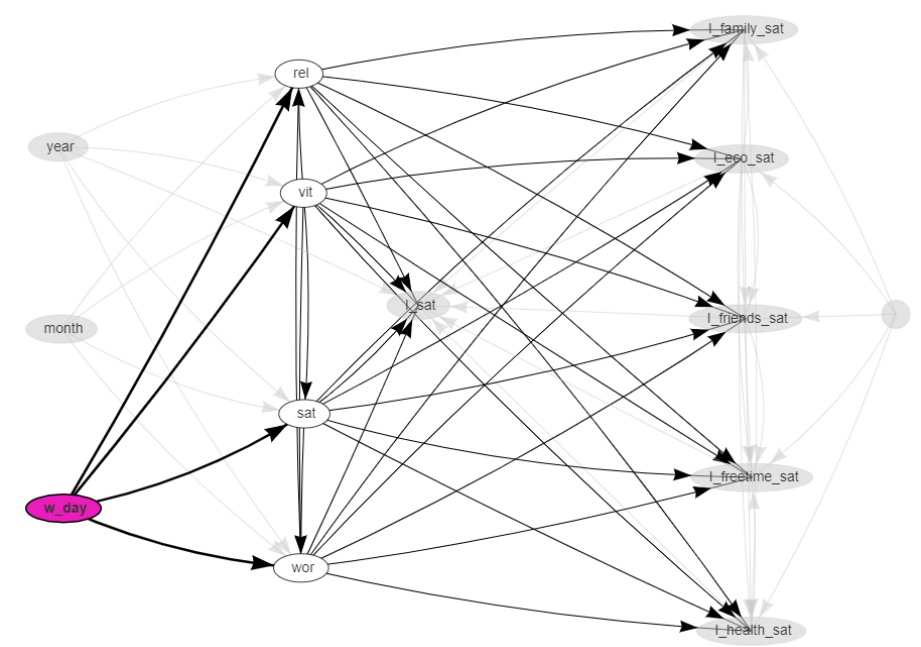
Figure 4. Social media data vs. survey data: Bayesian network highlighting the day of the week. The children nodes of the day nodes are in